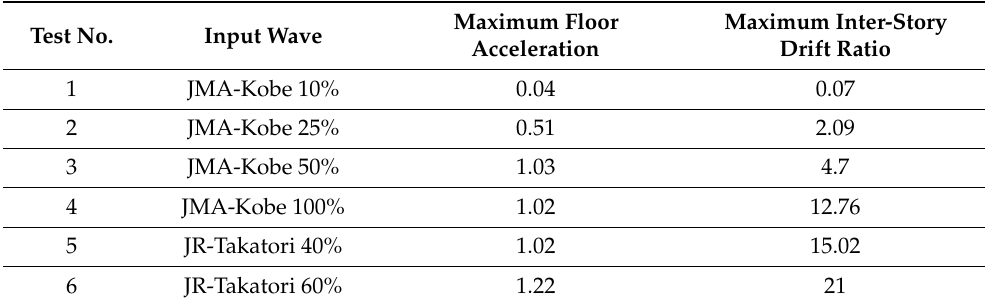
Table 8. Root-mean-square percentage error for maximum floor acceleration and maximum inter- story drift ratio (experimental and analyzed results, unit: